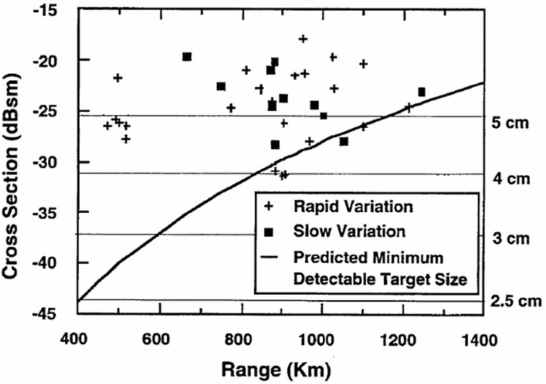
Figure 1. Results from TRADEX 1994 stare-and-chase activities [14]. Reprinted with permission courtesy of MIT Lincoln Laboratory, Lexington, Massachusetts.